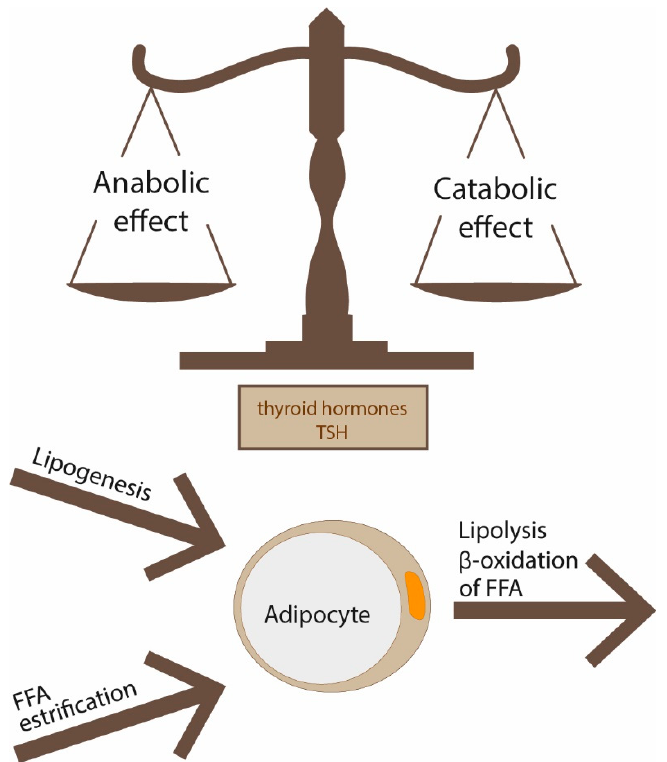
Figure 1. The size of adipocytes is the result of the balance between lipogenesis, lipolysis and fatty acid oxidation; these processes are regulated by THs and TSH.